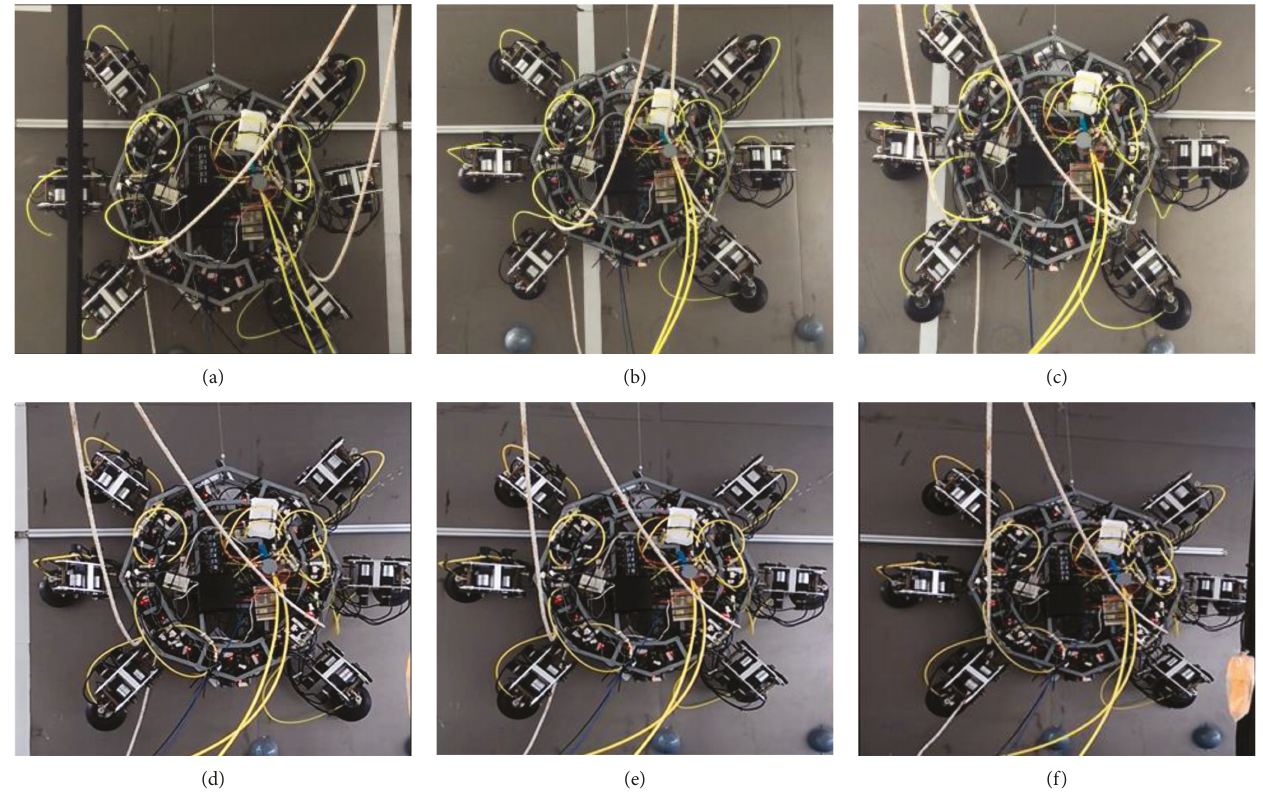
Figure 19: The wall-climbing hexapod robot walks on vertical wall with horizontal direction by using the triangular gait